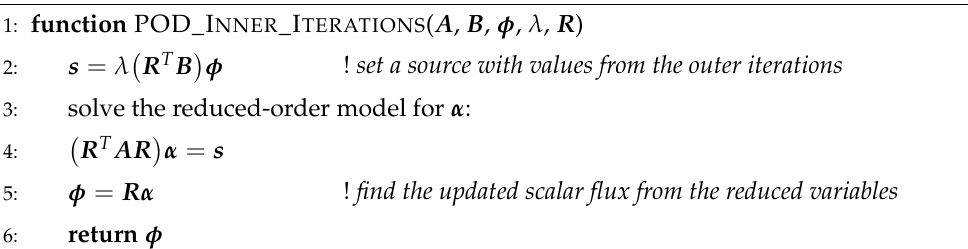
Algorithm 3 POD-based reduced-order model: inner